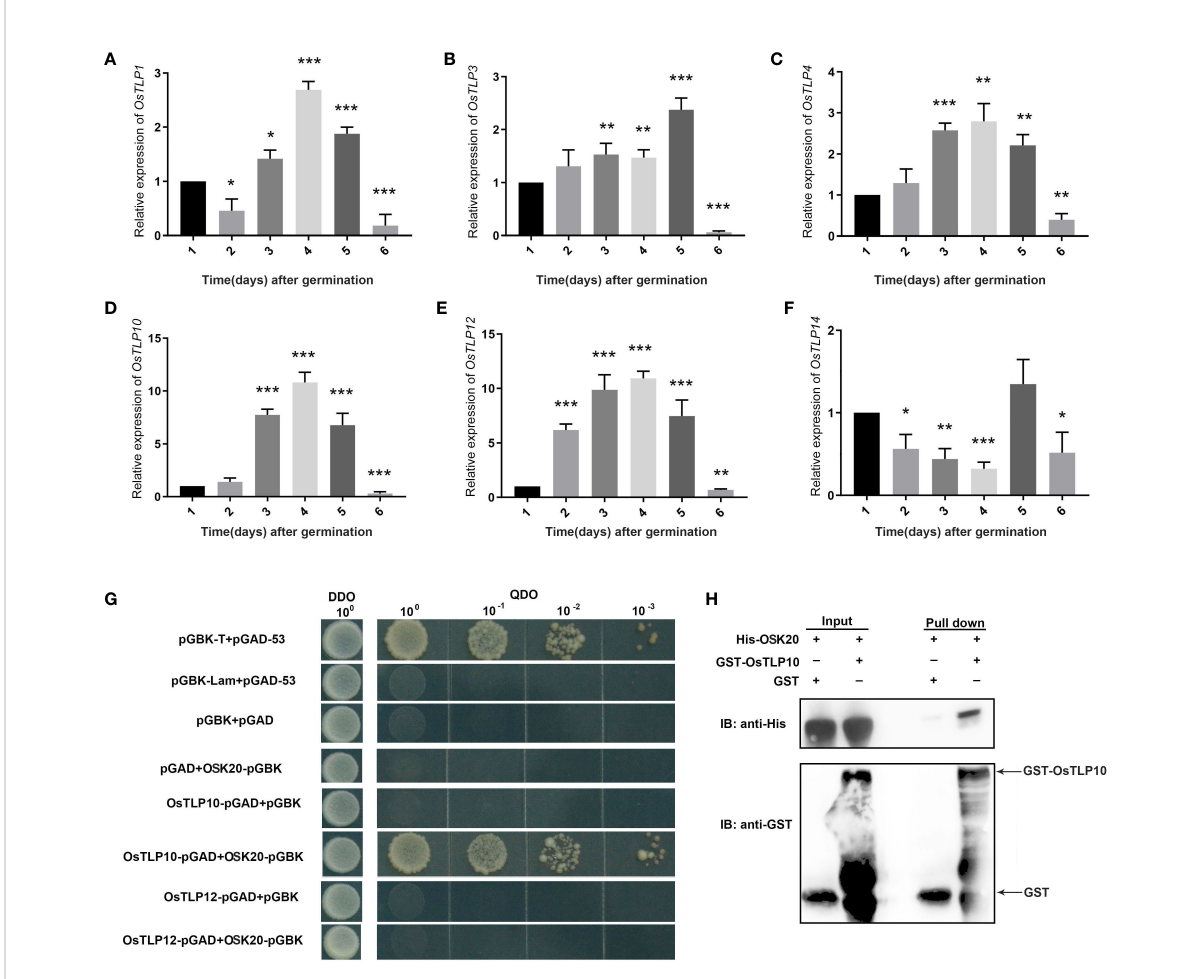
FIGURE 10 Expression levels and interaction ability of OsTLPs. (A-F) Relative expression of OsTLPs in seeds after germination. Data represent mean ± SD from three biological replicates (Student ’ s t test, *P < 0.05, **P < 0.01, ***P < 0.001). (G) Interaction of OsTLP10 and OsTLP12 with OsK20 by yeast two-hybrid analysis. The full-length OsTLP10 and OsTLP12 were fused with GAL4 activation domain and OsK20 protein was fused with GAL4 DNA binding-domain, respectively. pGBK-T, pGAD-53 were used as positive control and pGBK-lam, pGAD-53 were chosen as negative control. (H) Pull down assay was employed to show the interaction relationship between OsTLP10 and OsK20. IB, immunoblotting. The fusion proteins His-OsK20 and GST-OsTLP10 were detected by anti-His and anti-GST antibodies,